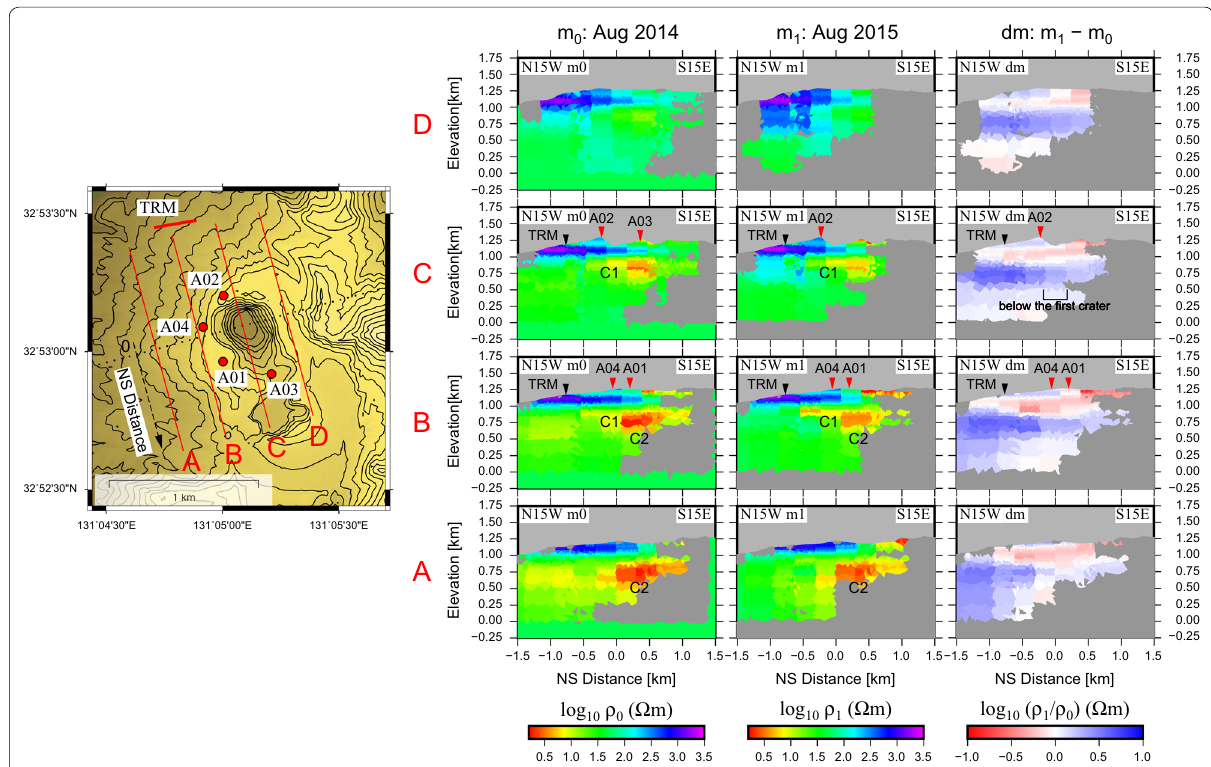
Fig. 3 Vertical slices in the N15°W directions. The formats of panels are the same as Fig. 2